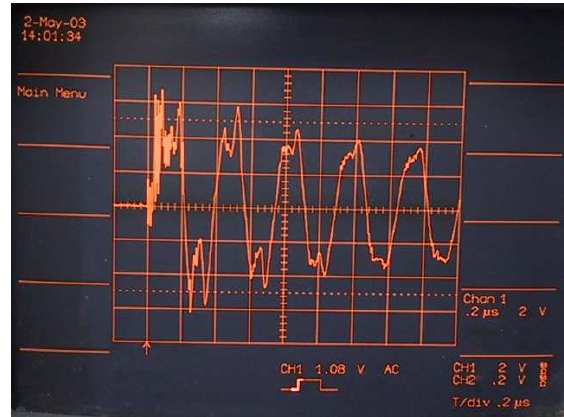
Fig. 5. Echoes from the ionosphere due to the pulse antenna seen in Fig. 1. The upper trace is the signal from the current monitor. The lower trace is the signal from a remote receiving (ionosonde) antenna at HIPAS showing an echo 1.9ms later, corresponding to a reflection from a critical layer at 280km. In this case the RF pulse was only 9.3kW.